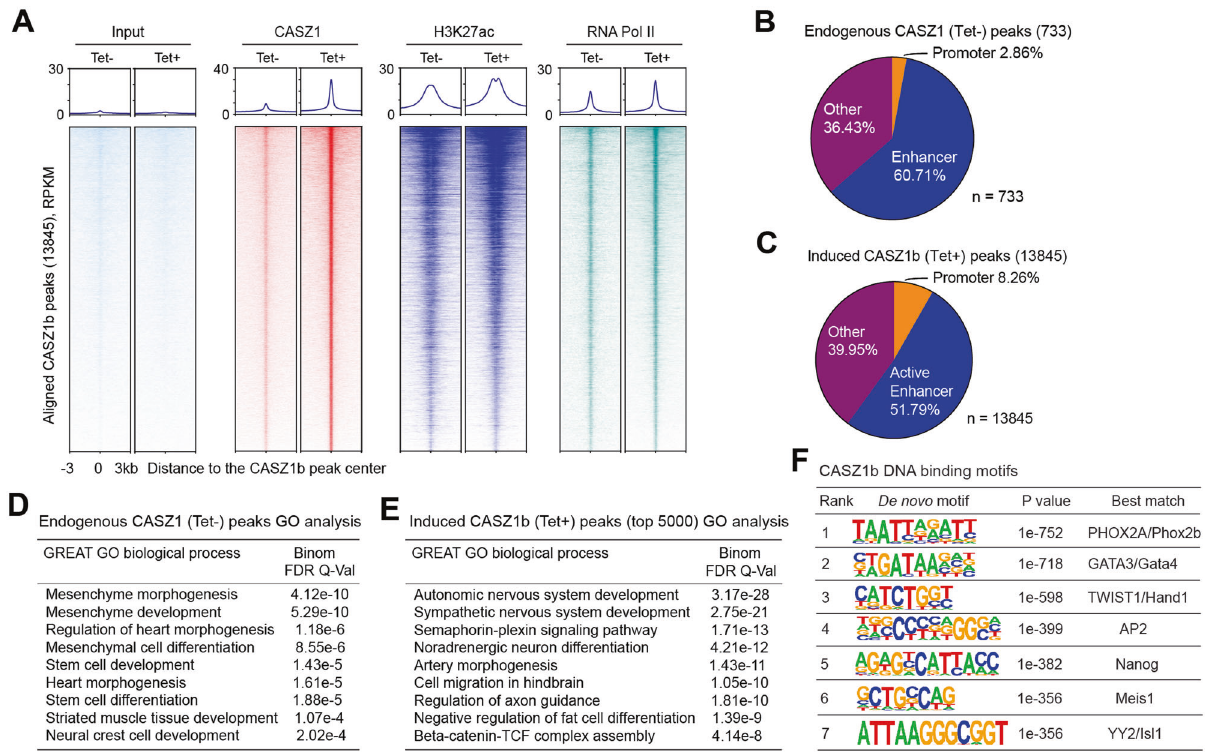
CASZ1 binding sites are associated with mesenchyme, heart and neural crest development. E GREAT GO biological process analysis shows that the CASZ1b binding sites are associated with sympathetic nervous system development and noradrenergic neuron differentiation. F